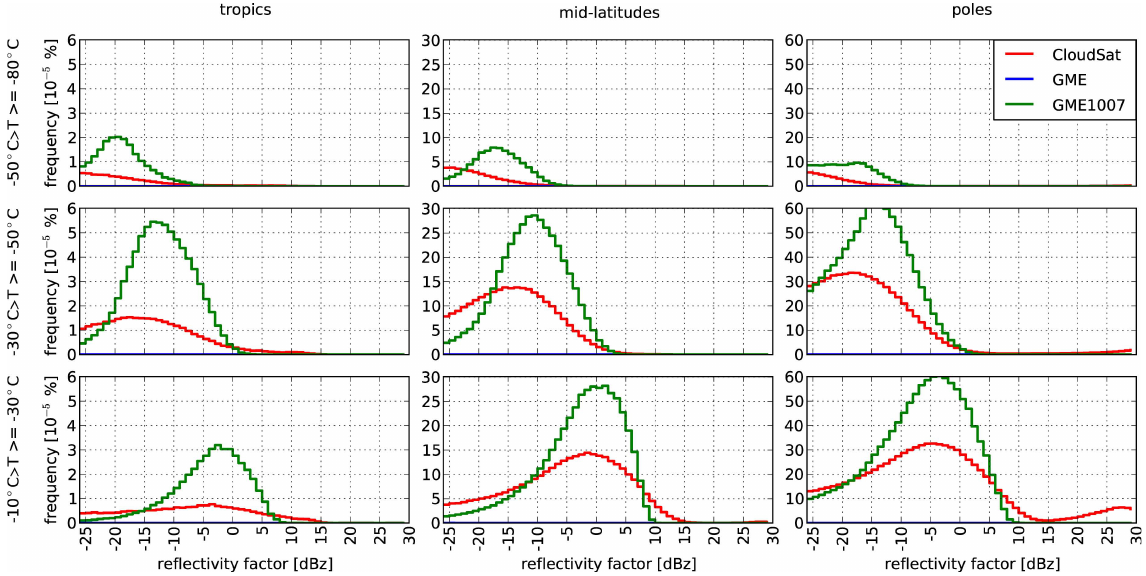
Fig. 7. Histograms of frequency distributions of reflectivity factor for 1 July 2009 to 31 October 2009 for three temperature ( − 10 to − 30 ◦ C (bottom), − 30 to − 50 ◦ C (middle), − 50 to − 80 ◦ C (top)) and three latitudinal (tropics (left), mid-latitudes (middle), polar regions (right)) regimes. Red: CloudSat; green: GME1007. Normalized with total number of